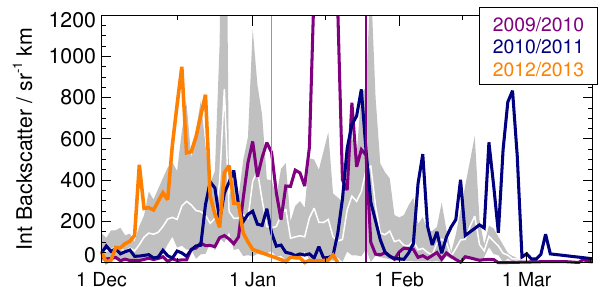
Figure 4. Vortex-integrated CALIPSO backscatter (sr − 1 km) at 490K, proportional to the total liquid particle surface area within the vortex, as a function of day in 2012/13 (orange), 2010/11 (blue), and 2009/10 (purple) compared with the range (grey shading) and average (white line) for the other years in 2006/07 through